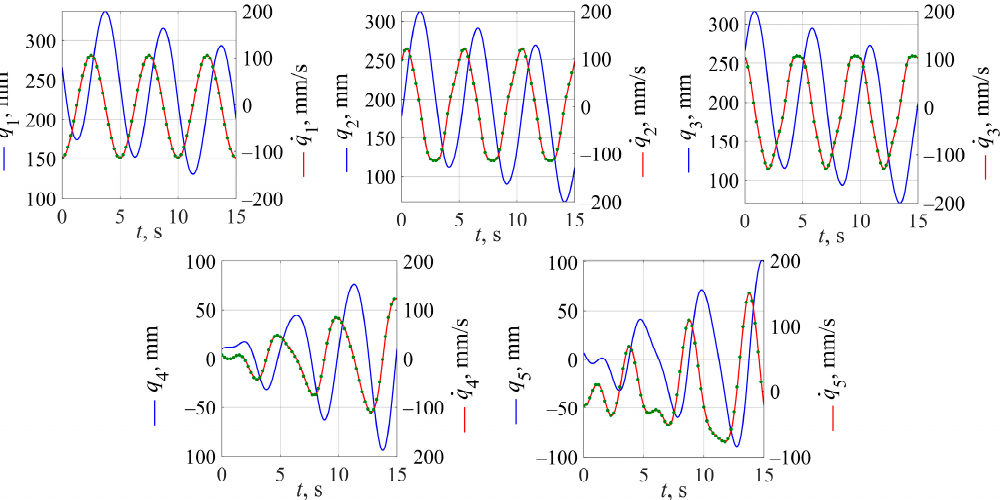
. q according to the proposed algorithm; ; red lines— according to the proposed . 𝐪𝐪̇ 𝐪𝐪 𝐪𝐪